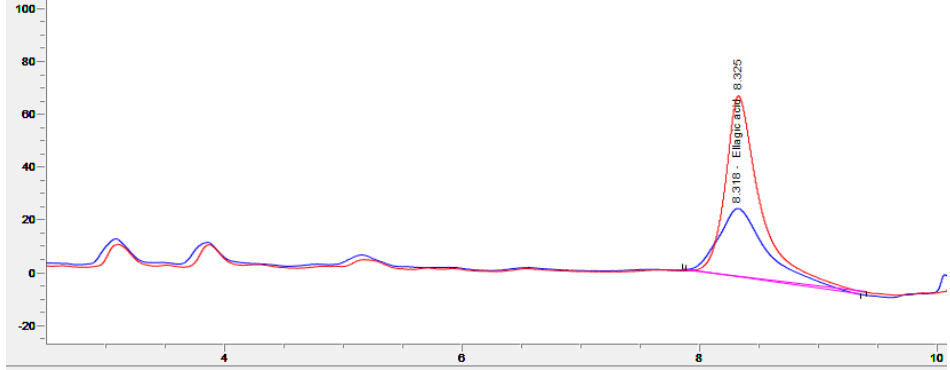
Figure 2. Chromatogram (260 nm) of an extract from walnut press cake (blue), and the same sample spiked with ellagic acid (red). Table 1. EA liberation from SSF of WPC using A. oryzae , R. oligosporus , and in coculture, n = 3 ( ± SD).